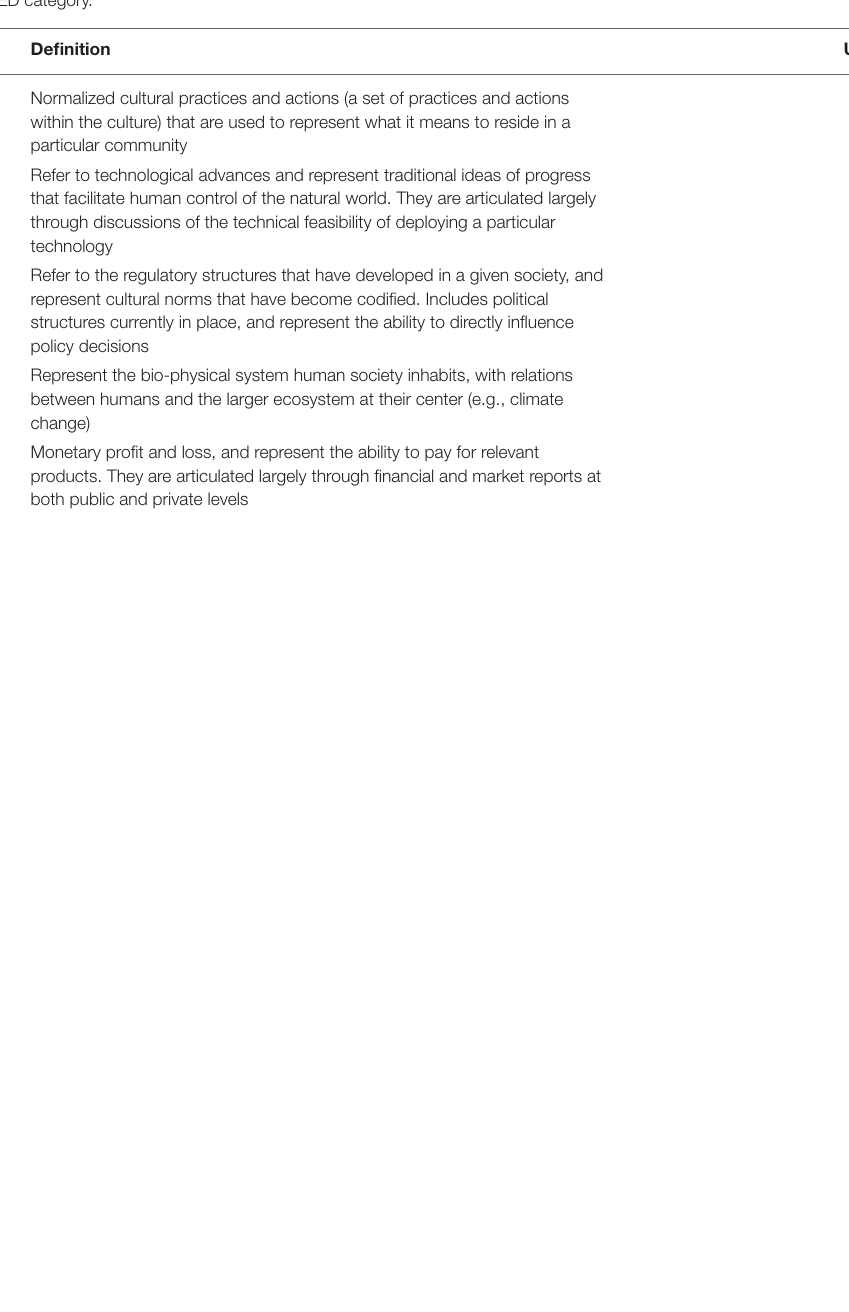
Table A1 | Number of utterances per SPEED